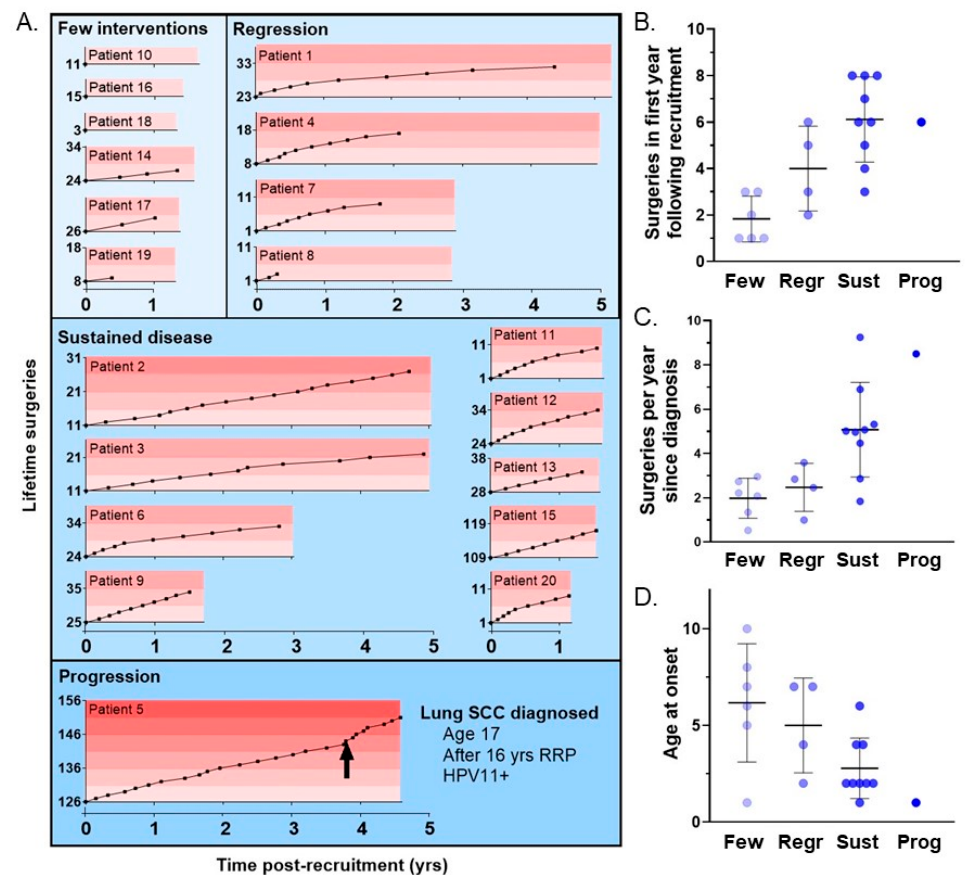
Figure 3. Patient clinical course categorized by low surgical frequency, sustained disease, disease regression, or disease progression ( A ) Clinical course per patient with the y-axis starting at the surgical number at the time of recruitment. Patients were categorized by few surgical interventions (defined as ≤ 2/year), disease regression (defined as a decrease to ≤ 1/year), sustained disease, or disease progression (diagnosis of lung SCC indicated by arrow). Across the clinical course groups, the number of surgeries in the first year following recruitment ( B ), the average surgeries per year since disease onset ( C ) and the age at disease onset ( D ) show statistically significant differences across the groups ( p < 0.001, p = 0.04, and p = 0.02, respectively).